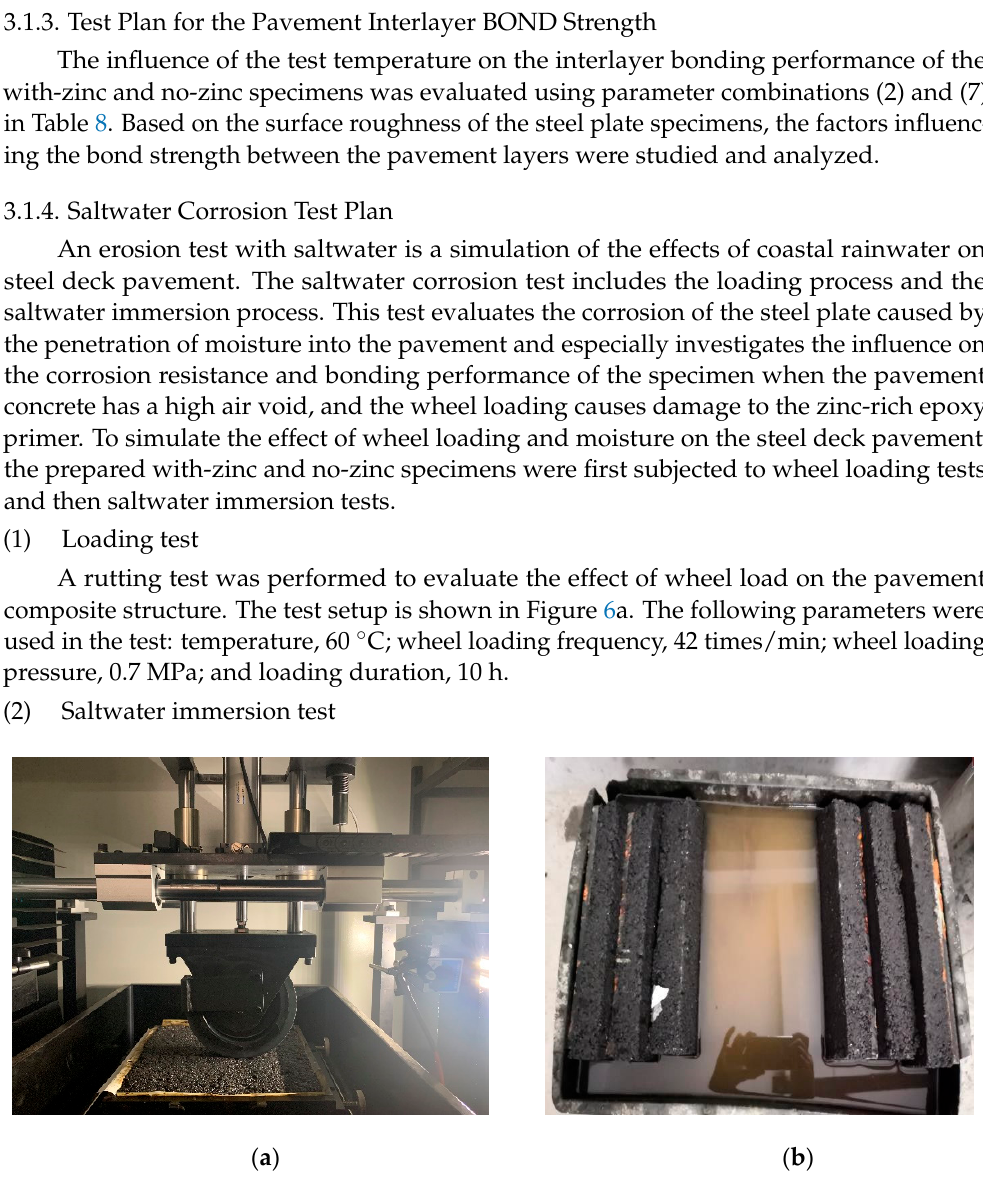
Figure 6. Setups for ( a ) the wheel loading test and ( b ) the saltwater immersion test.